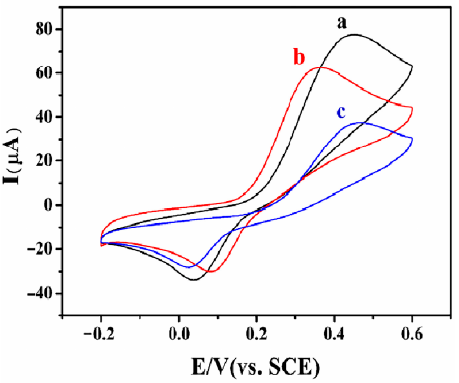
Figure 6. CV curves of AuNPs@COFs (a), GCE (b) and COFs (c) in 0.1 mol/L PBS electrolyte con- taining 0.6 mmol/L ractopamine.